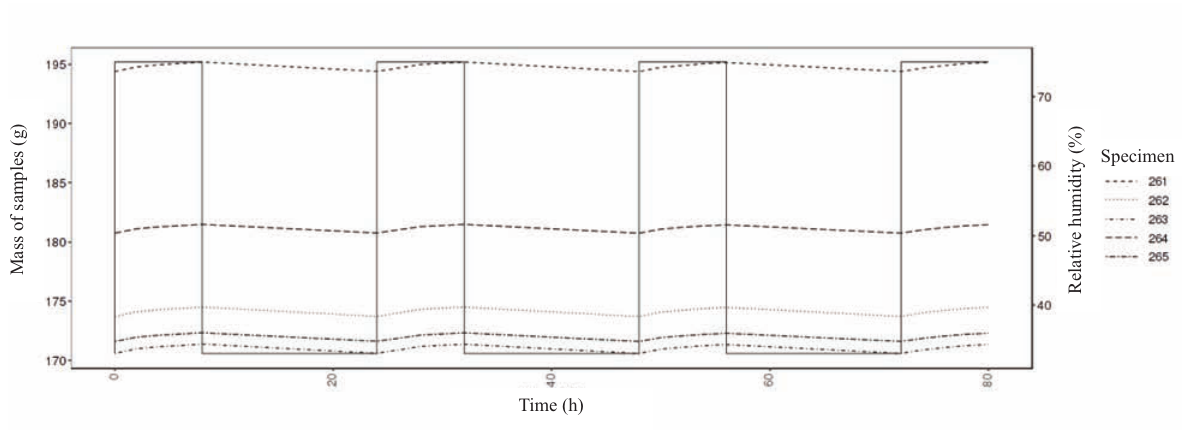
Fig. 2. The whole mass (g) of five samples (plaster group 5) in the cycles of Nordtest. The change in moisture cycles (RH 33% and RH 75%) in the climate chamber is portrayed by a continuous